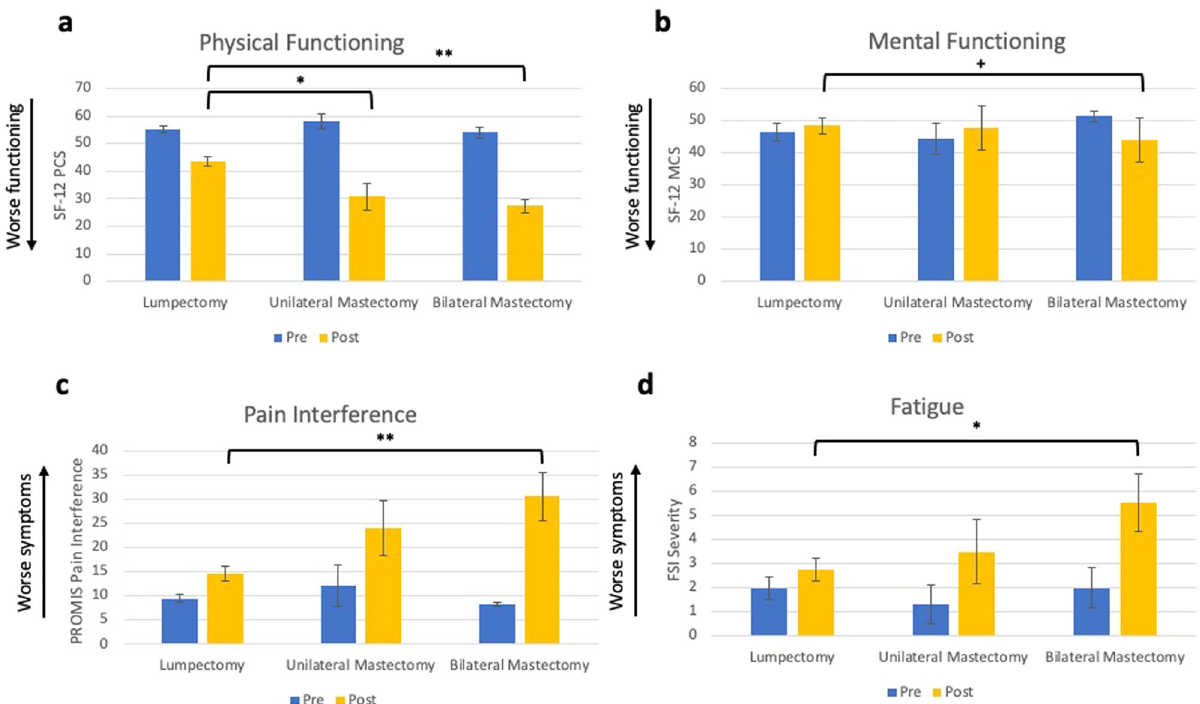
Fig. 1 Study 1 pre- and post-surgical HRQOL outcomes. Average levels of physical functioning ( a ), mental functioning ( b ), pain interference ( c ), and fatigue ( d ) are presented with error bars representing standard errors. Differences between groups for post-surgical values are represented by bars with * indicating statistically signi fi cant differences using ANCOVA (* = p < 0.05, ** = p < 0.01) and + indicating a marginally signi fi cant difference ( + = p = 0.08).